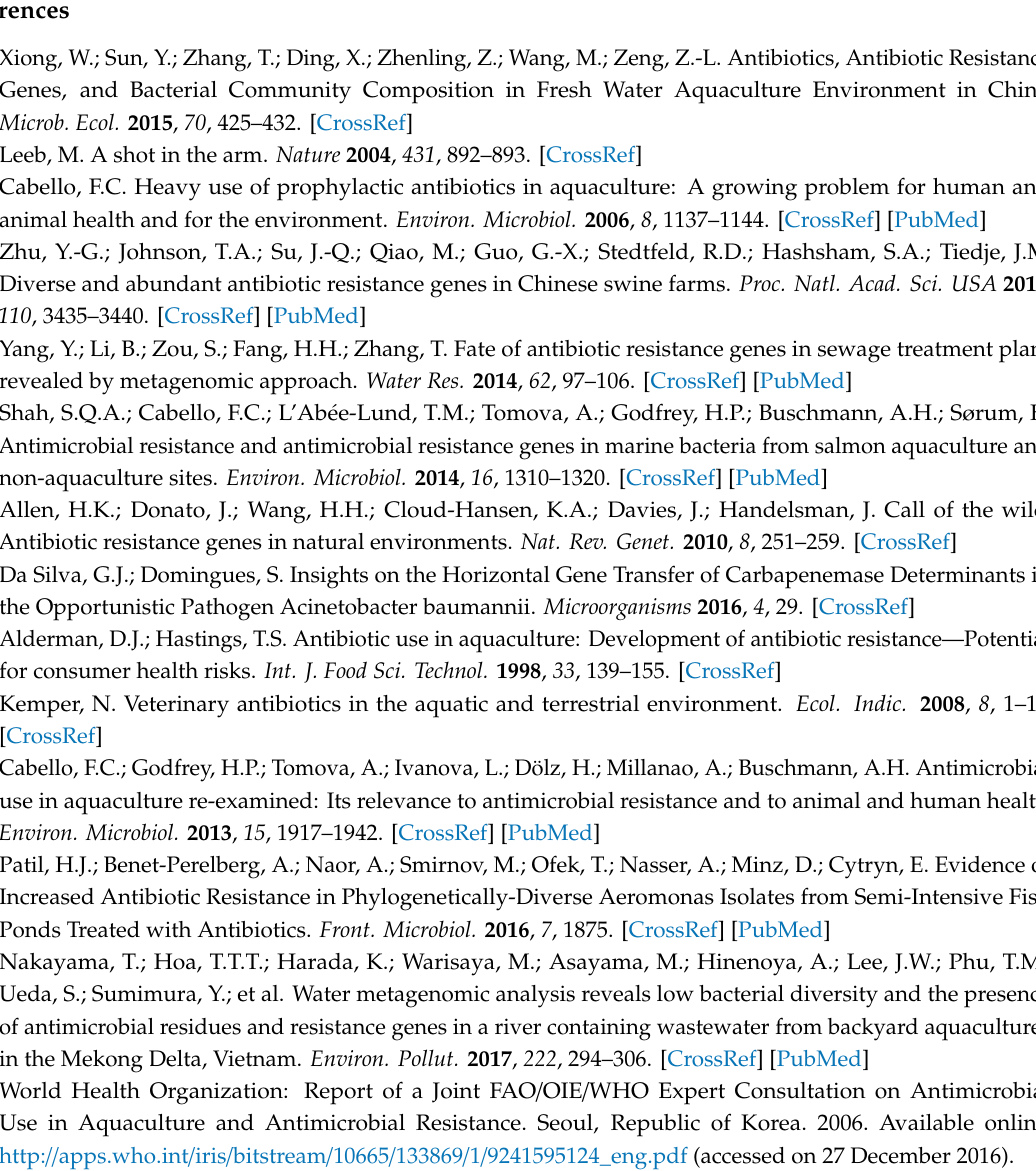
Samples description. Table S2 : Physicochemical parameters at the study site during sampling. Table S3 : Antibiotic resistance gene hits extrapolated from fishpond-3 and reservoir shotgun metagenomes using COSMOSID and CARD bioinformatic pipelines. Genes with less than ten hits are not shown. Table S4 : Pearson’s correlation coe ffi cients followed by Canonical Correspondence Analysis (CCA) between phyla (with relative abundance > 5.0% at any of the sampling profile), ARGs, integrase genes and environmental parameters (temperature and